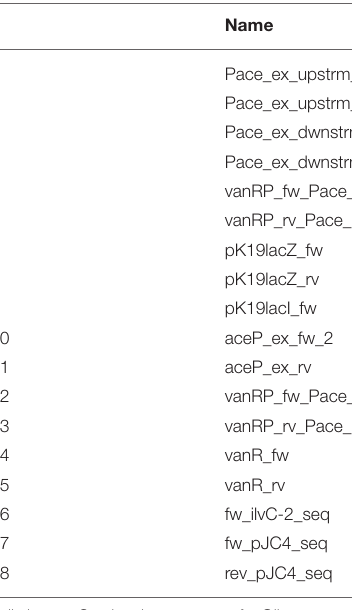
TABLE 2 | Oligonucleotides used in this